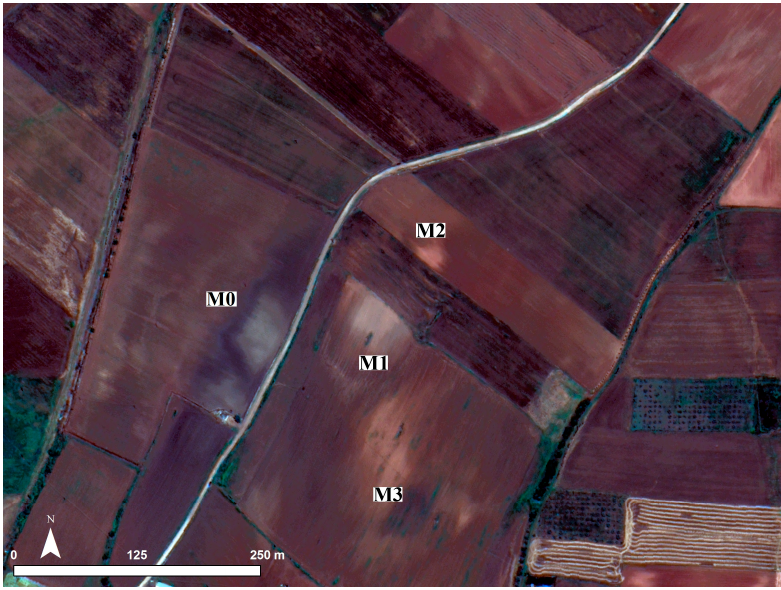
Figure 2. The true color WorldView-2 imagery (acquisition date: 4 June 2012) revealing soil marks related to the settlement.